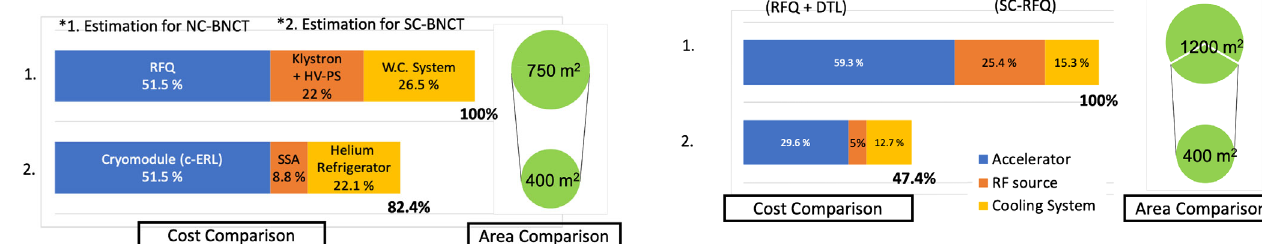
FIG. 16. Relative ratio of the estimation of NC-BNCT (RFQ þ DTL) to that of SC-BNCT. Histogram and circle graph represent the cost and the area estimated by J-PARC and c-ERL at KEK,